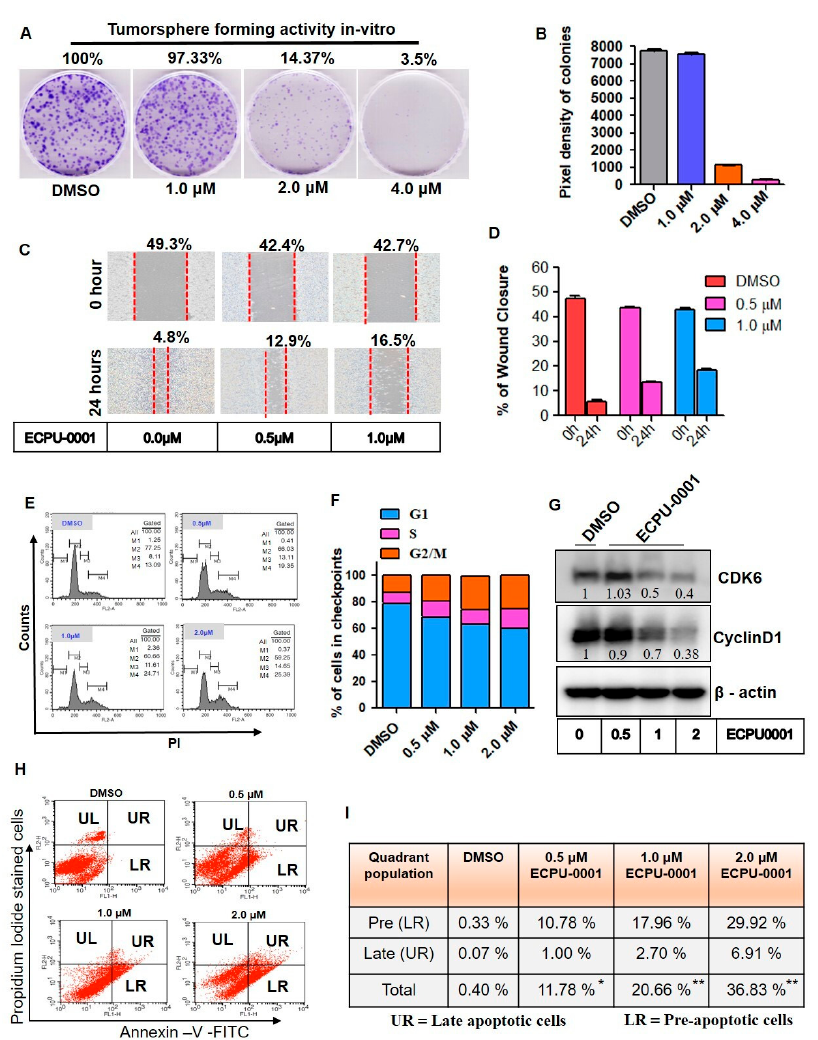
Figure 5. ECPU-0001 inhibits cancer growth, migration via CyclinD1 / CDK6 mediated cell cycle G2 / M phase arrest. ( A ) Colony formation assay was done to investigate long-term e ff ect of ECPU-0001 on proliferation of lung cancer tumorigenic cells. Data are means ± SD of three independent experiments. Opted Scale bar: 20 × ( B ) Tumorspheres or colonies were analyzed and pixel density was determined using ImageJ software. ( C ) To elucidate the e ff ect of ECPU-0001 on A549 cell invasion and migration, briefly cells were propagated in 6-well plates until it covered near to 80% confluency. Then, each well scratched with 200 µ L tip equally under the same condition. The wounded A549 cells-layered cultured and incubated in without FBS RPMI-1640 medium. Then cells were treated medium which containing 0, 0.5, and 1.0 µ M of ECPU-0001 for 24 h. Scale bar: 20 × ( D ) Percentage of wound healed area was measured using ImageJ followed standard protocol. ( E , F ) The cell cycle sub-phase in di ff erent checkpoints was analyzed using FACS. A549 cells were treated with vehicle (DMSO; control), 0.5 µ M, 1.0 µ M and 2.0 µ M ECPU-0001 for 24 h, followed by FACS protocol. In the histogram peak, the horizontal line depicts the intensity of propidium iodide that is content of DNA while vertical line reveals total cell number. ( G ) Immunoblot analysis of cell cycle regulator proteins. ( H ) ECPU-0001 induces pre / late apoptosis and in-cell engagement of BCL-2. ECPU-0001 accelerate lung cancer cell apoptosis through enhancing the activity of Annexin-V-FITC / PI positive cells. Apoptosis was tested by FACS analysis after A549 cells were treated with ECPU-0001 for 24 h. ( I ) The apoptotic (pre and late apoptotic cells) percentage was evaluated and shown in